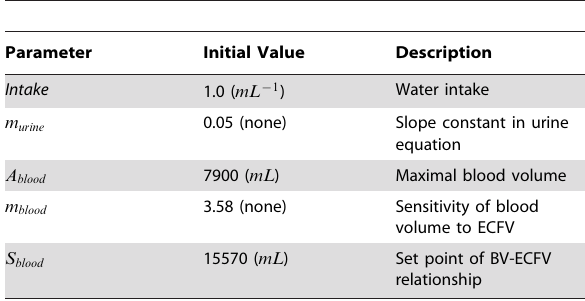
Table 3. Parameters of fluid